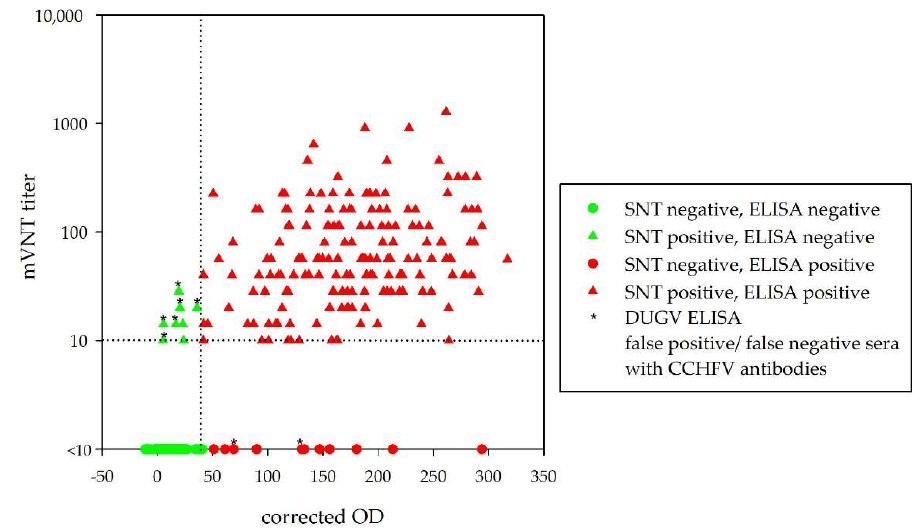
Figure 2. Correlation of mVNT titers and corrected OD values: only 8 sera were false-negative (green triangles) and 12 sera false-positive (red dots) out of 300 tested cattle sera. Six false-negative sera and two false-positive sera actually yielded CCHFV antibodies (marked with *).